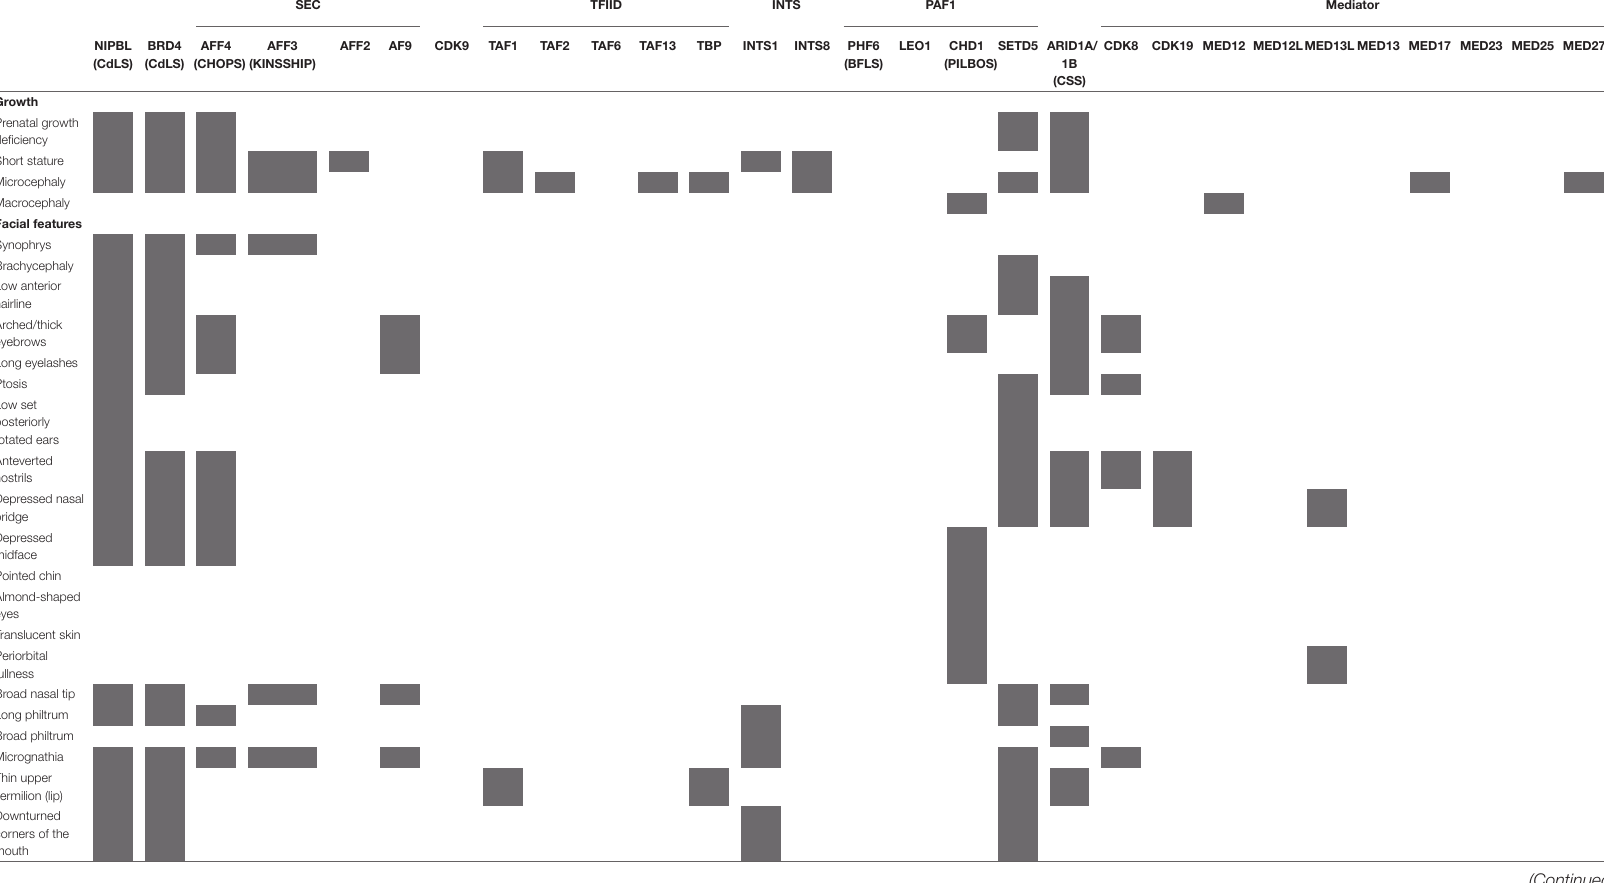
TABLE 1 | Overview of clinical symptoms. SEC TFIID INTS PAF1 Mediator